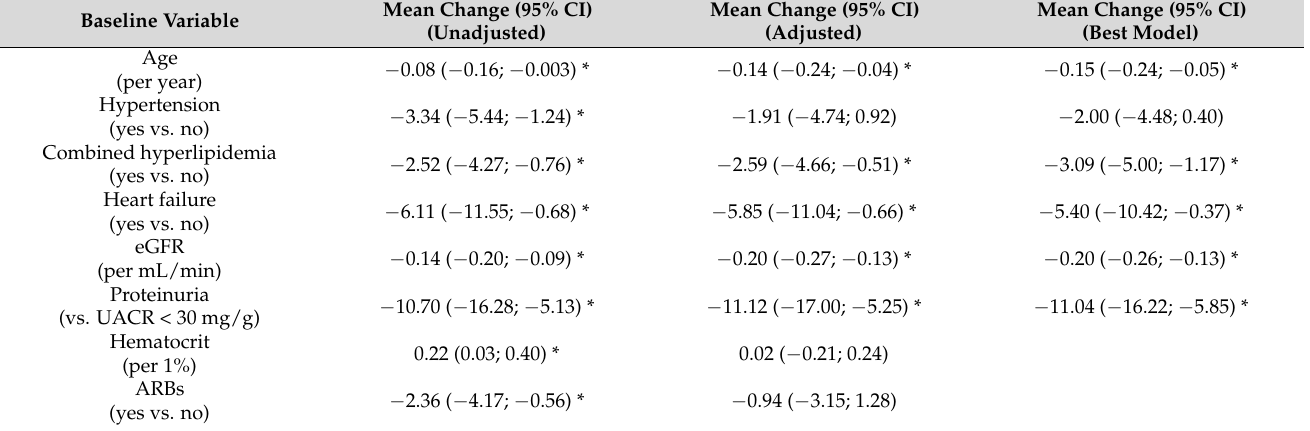
Table 2. Predictive factors of eGFR decline after canagliflozin therapy. Data: mean difference (95% CI). UACR: urine albumin-to-creatinine ratio. ARBs: angiotensin II receptor blockers. * p <